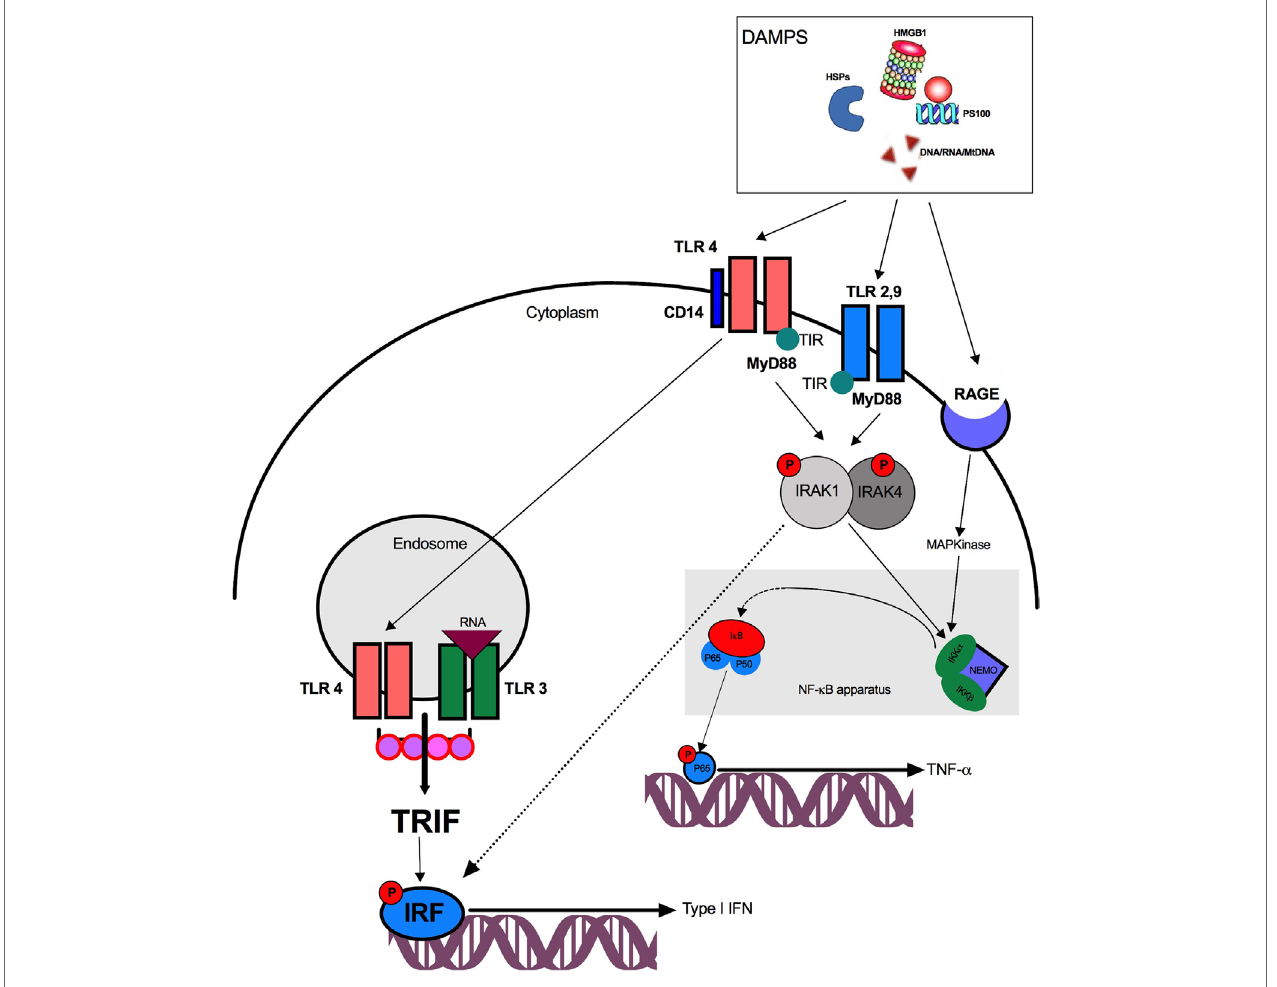
FiGURe 1 | Pathway activation after damage-associated molecular patterns (DAMPs) stimulation. DAMPs are recognized by surface or endosomal TLRs and trigger either TRIF and NF- κ B activation. TLR4, toll-like receptor 4; TIR, toll/interleukin-1 receptor; DNA, desoxyribonucleic acid; RNA, ribonucleic acid; IRF, interferon regulatory factor; TRIF, TIR domain-containing adaptor protein inducing interferon β ; NF- κ B, nuclear factor κ B; NEMO, NF- κ B essential modulator; IRAK, IL-1 receptor-associated kinase-4; MyD88, myeloid differentiation protein 88; RAGE, receptor for advanced glycation end products; HMGB1, high-mobility group box 1; HSP, heat-shock protein; IKK, I κ -B